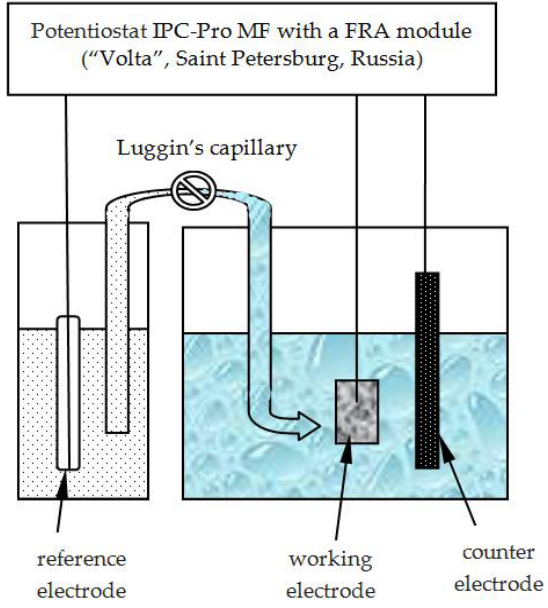
Figure 2. Layout of the electrochemical cell for EIS studies.